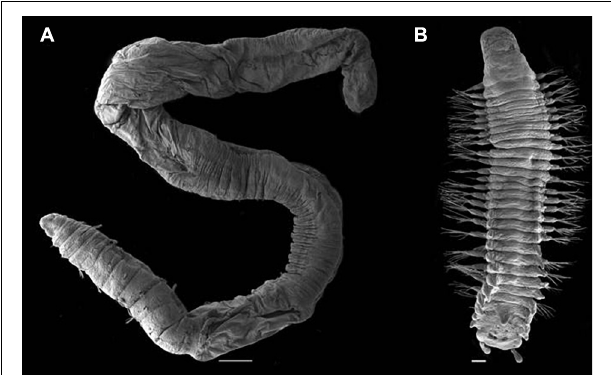
FIGURE 10 | Photographic plate demonstrating examples of the Polychaeta (A) Capitella sp. (500 µ m scale bar) and (B) Mammiphitime sp. (100 µ m scale